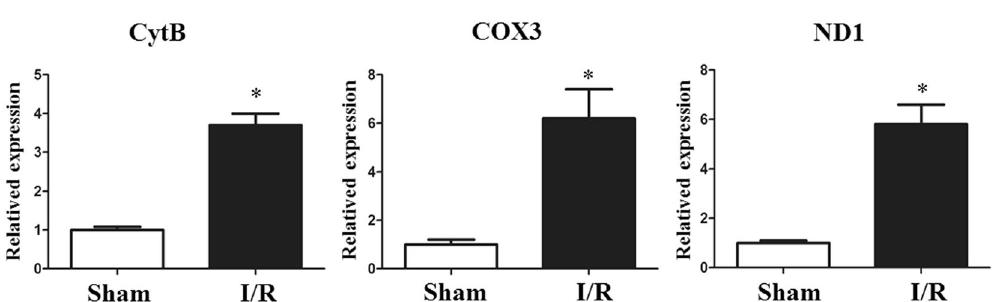
Figure 3. Intestinal I/R increases the mtDNA level in the circulation in vivo . Plasma mtDNA levels were significantly elevated in mice undergoing I/R compared with those in the sham group. The data were expressed as means ± SD. * p < 0.05 vs I/R